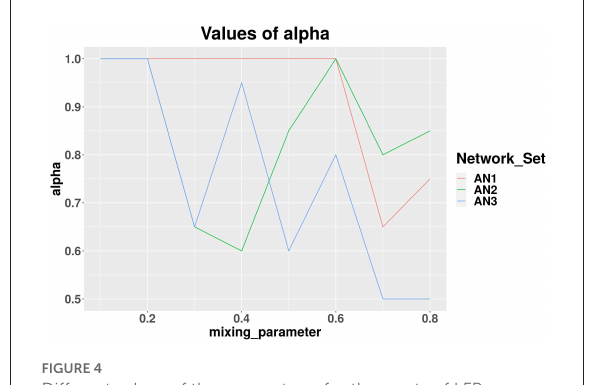
FIGURE4 Different values of the parameter α for three sets of LFR benchmark networks AN 1 , AN 2 , and AN 3